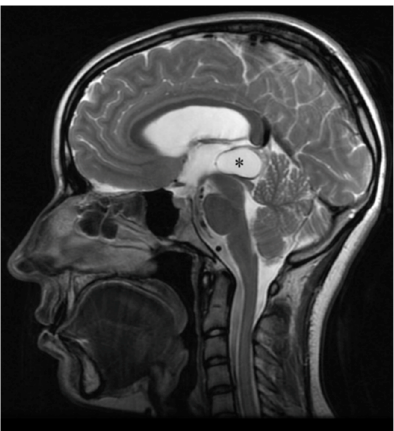
Figure 11. Pineal cyst MRI. The asterisk indicates the pineal cyst. Reprinted with permission from Májovský et al. (2017) [124]—Elsevier—2021 (License Number 5020240575766).